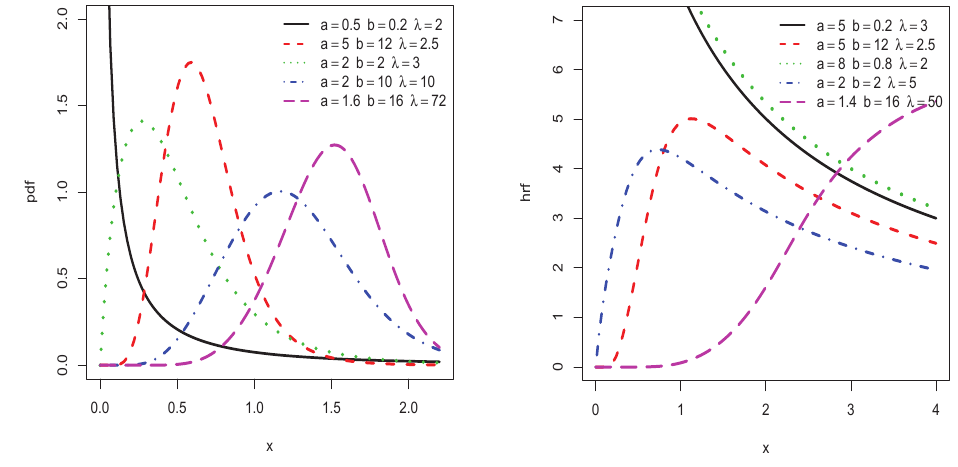
Figure 1. Plots of some probability density functions (pdfs) and hazard rate functions (hrfs) of the type I half-logistic inverted Kumaraswamy (TIHLIK)